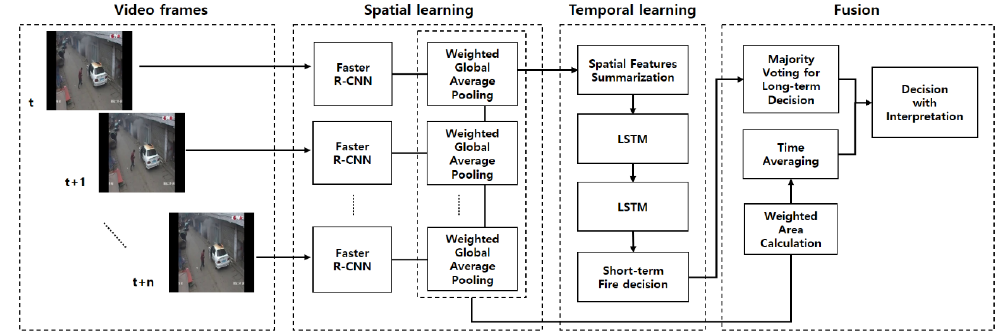
Figure 1. The proposed network architecture.